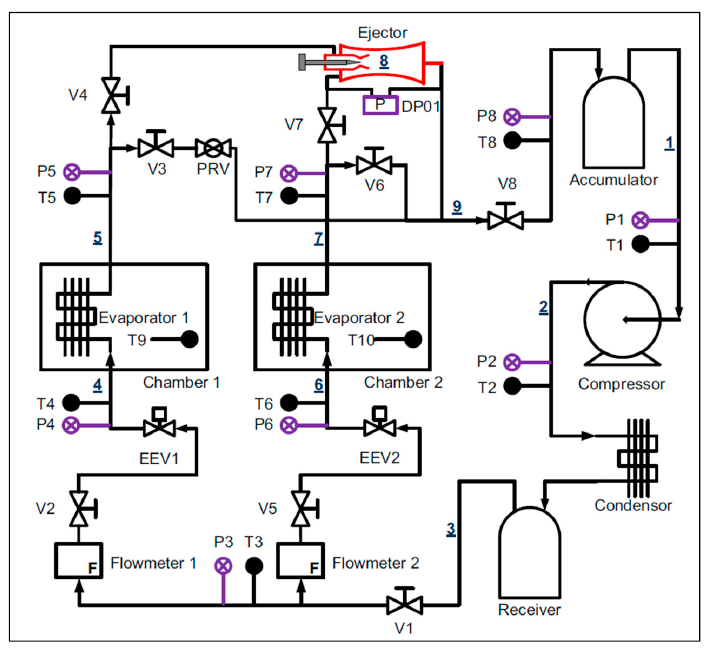
Figure 38. Multi-evaporator refrigeration system [343].